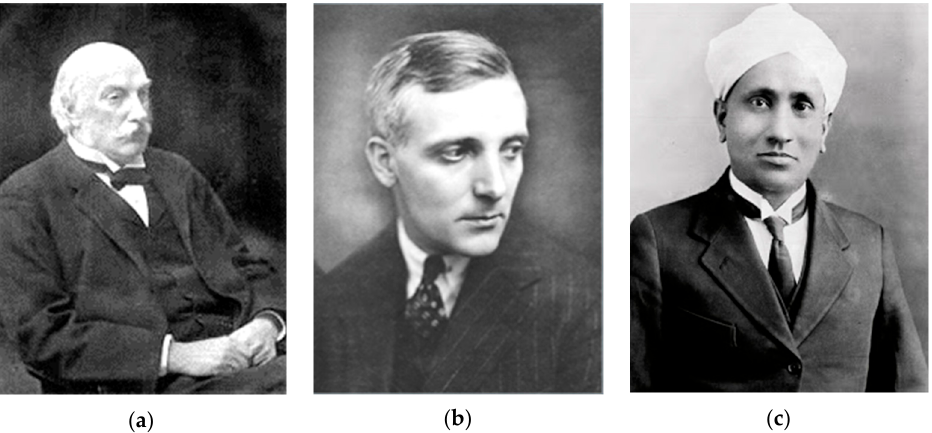
Figure 2. ( a ) John William Strutt (Lord Rayleigh); ( b ) Léon Brillouin; ( c ) Chandrasekhara Venkata Raman [6]. Raman